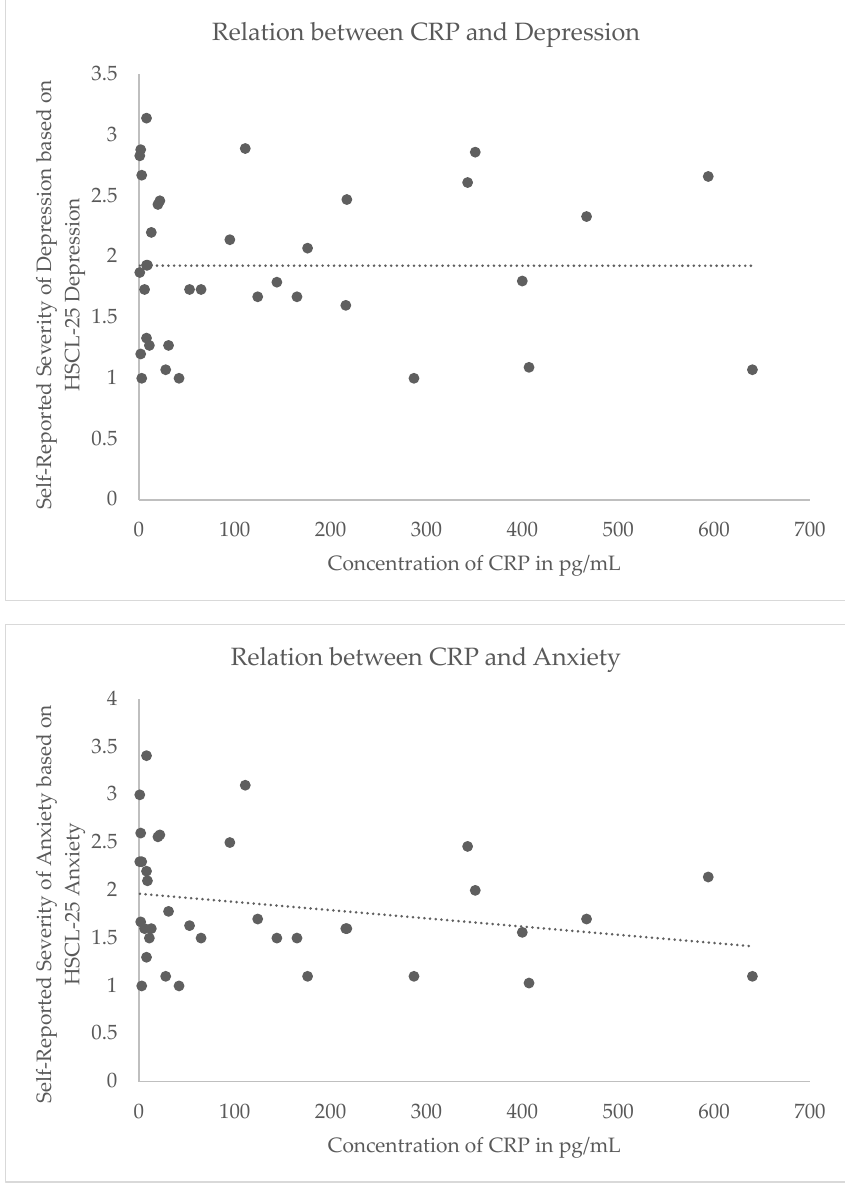
Figure 2. Steiger’s Z* revealed differential relations between C-reactive protein (CRP) and depressive symptoms (top) and CRP and anxiety symptoms (bottom), where no relation exists between the former and a slightly negative relation appears between the latter. While these relations were not significant, the difference in correlation coefficients was significant, indicating that there is a differential relation between inflammation and trauma-related psychopathology. All Y axes reflect concentration of CRP in pg / mL. X axes reflect self-reported symptom severity scores for the HSCL-depression index (range: 0–4) (top) and HSCL-anxiety index (range: 0–4)